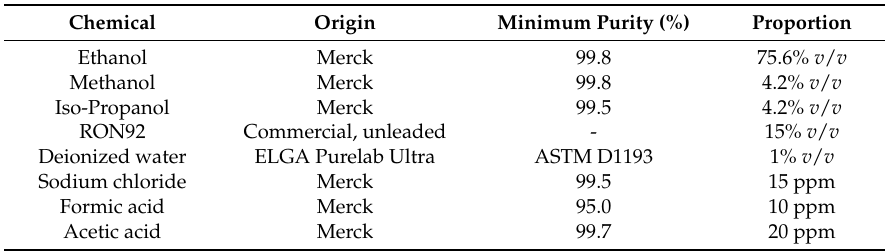
Table 1. The simulated ethanol fuel blend